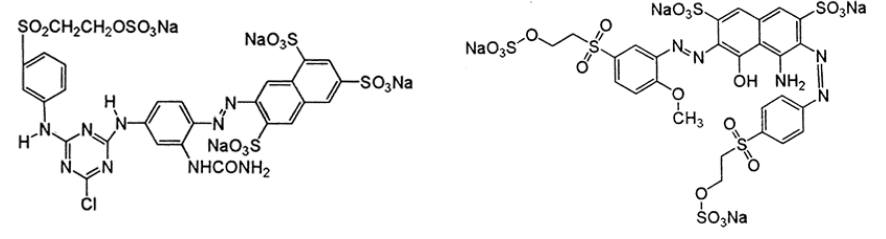
Figure 1. Structure of the industrial textile dyes used in photodegradation assays.